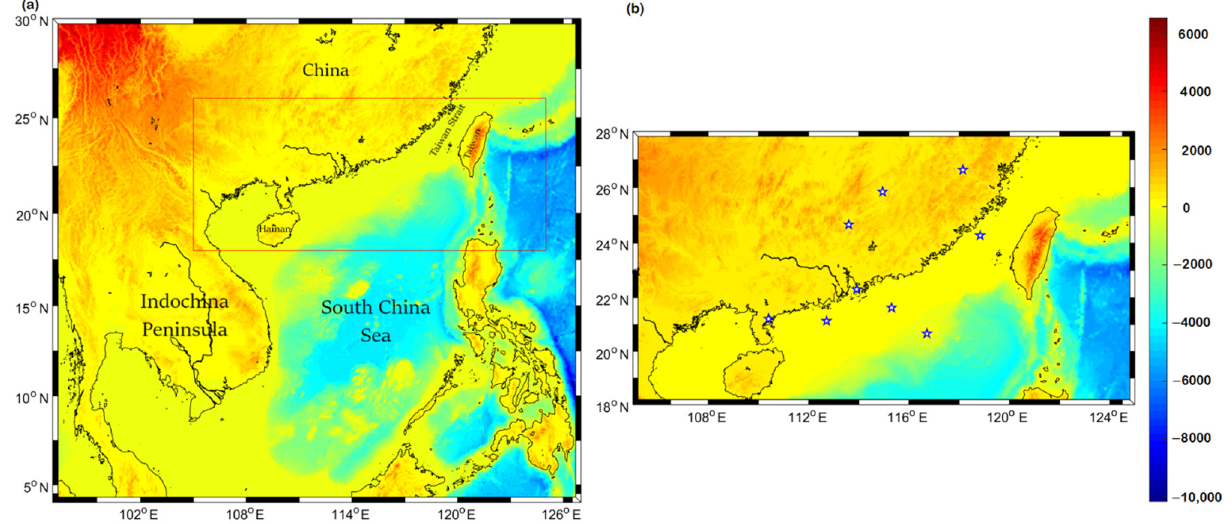
Figure 1. ( a ) Terrain and Bathymetry (m) of South China Sea and surrounding region from ETOPO2 data. ( b ) Southern China coast showing the shallow bathymetry. The point locations used in the following analysis are shown as blue stars.